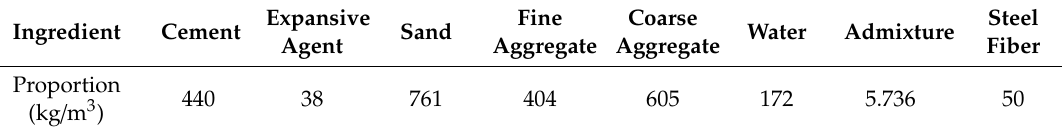
Table 5. Mix proportion of cement